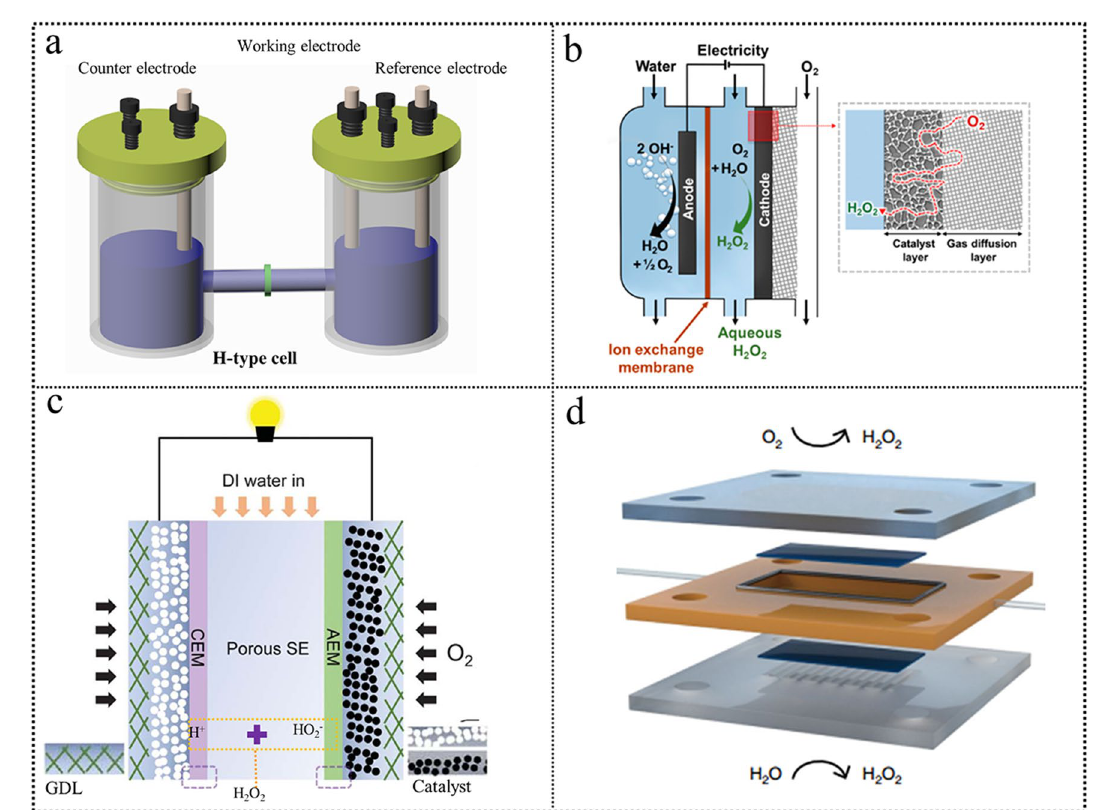
Fig. 13 a H-cell device. b Schematic of a continuous flow cell with a catalyst deposited on a GDE. Reproduced with permission [27]. Copy- right 2020, American Chemical Society. c Electrosynthesis of H 2 O 2 using a solid electrolyte. Reproduced with permission [171]. Copyright 2019, American Association for the Advancement of Science. d Schematic design of developed 2e − -WOR//2e − -ORR H 2 O 2 electrosynthetic cell. Reproduced with permission [174]. Copyright 2020, Springer Nature. (Color figure